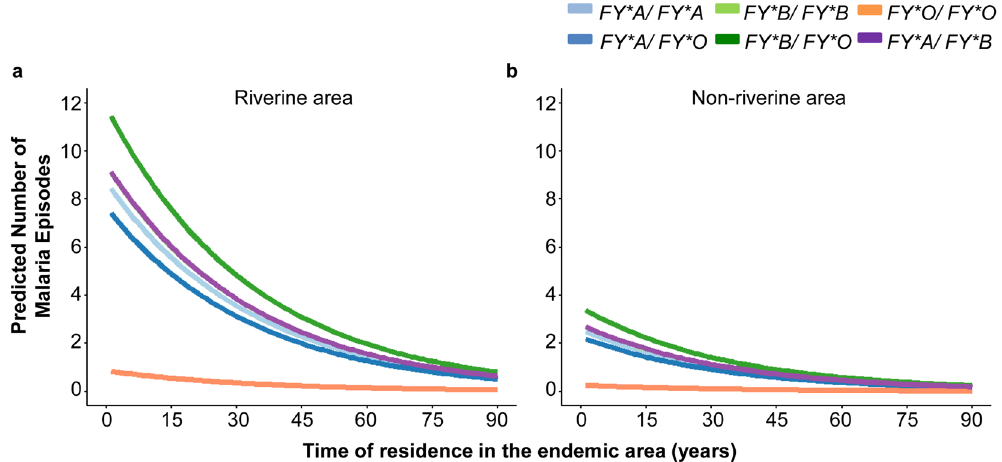
Figure 3. Analysis of the risk of clinical P. vivax malaria for the Rio Pardo population. The predicted number of clinical malaria episodes according to the DARC genotype, time of residence in the Amazon region and place of residence in the Rio Pardo community were derived from the Zero-inflated Poisson regression model. ( a ) Area along or close to the Rio Pardo stream with a higher risk of malaria infection (Riverine area) and ( b ) Non- riverine area with a lower risk of malaria